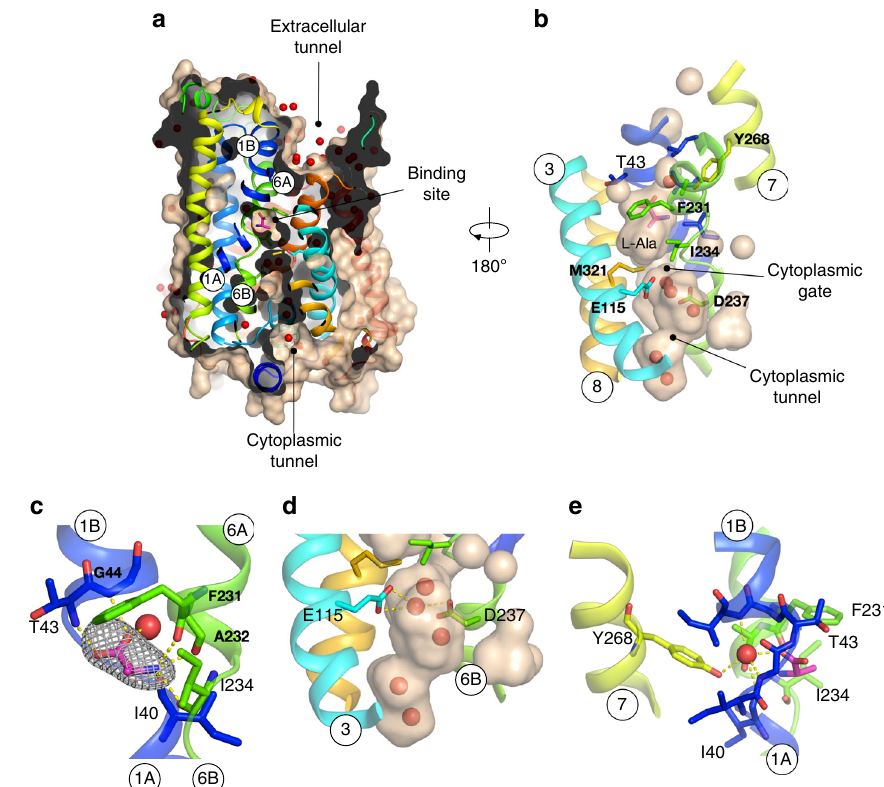
Fig. 2 Structure of the amino acid binding site. a Molecular surface representation of GkApcT showing the bound L -Ala ligand and position of the solvent fi lled extracellular and cytoplasmic tunnels with water shown as red spheres. b Zoomed in view of the ligand binding site, showing the location of waters in the cytoplasmic tunnel (brown shading) and location of the cytoplasmic thin gate. c View of the bound L -Ala ligand, showing the mFo-DFc difference electron density map contoured at 3 σ , grey. d Zoomed in view of the cytoplasmic tunnel, showing the interaction between the acidic residues in TM3 and 6. e View of the water molecule coordinating the α -carboxylate group of the L -Ala